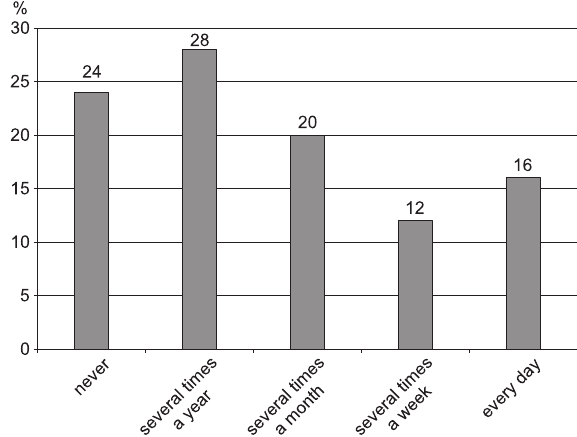
Fig. 4. The frequency of the respondents’ visits at Asnyk Square